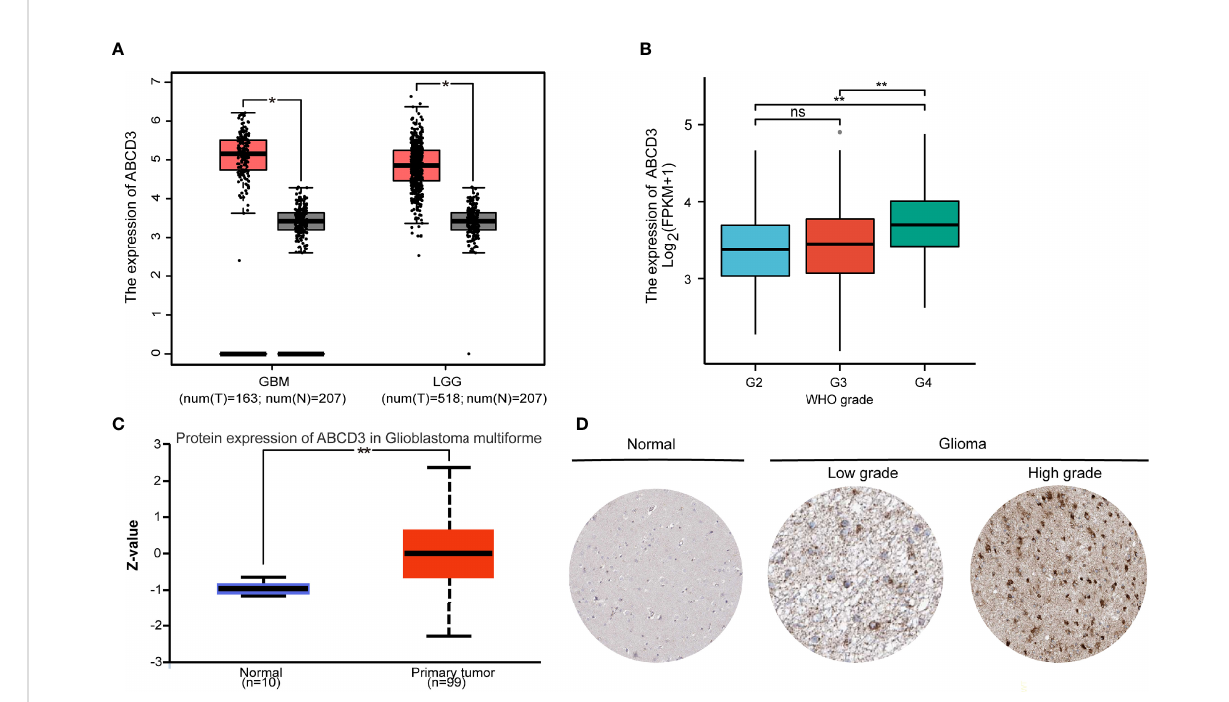
FIGURE 2 The mRNA and protein expression levels of ABCD3 are upregulated in glioma samples. (A) Differential expression of ABCD3 in both GBM and LGG compared with matched control samples. (B) Differential expression of ABCD3 in different glioma grades. (C) Differential ABCD3 protein expression levels in glioblastoma compared with normal tissues based on the data from the CPTAC. (D) Immunohistochemistry images of ABCD3 protein expression in glioma tissues and their normal controls. ns, no signi fi cance. *, P < 0.05; **, P <